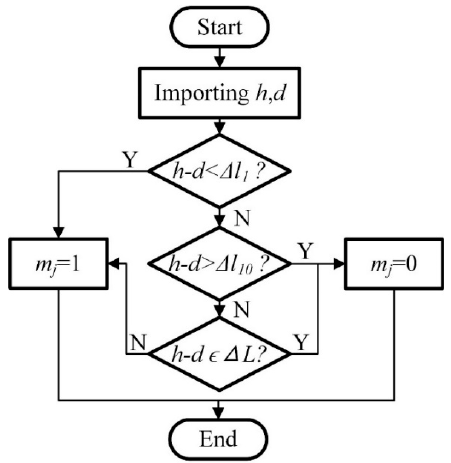
Figure 2. Flow chart to judge the rationality of the fault-originated section.